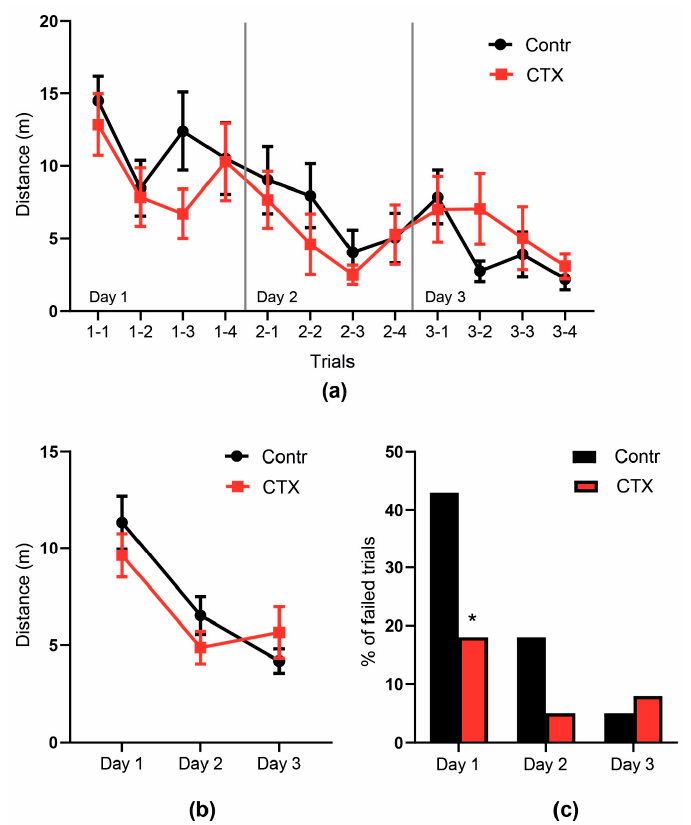
Figure 6. The behavior of CTX-treated rats in the Morris water maze. ( a ) distance traveled from the start point to the hidden platform during the 90-s trial, ( b ) the rate of failed trials during each day, * significant differences between the groups, Fisher’s exact test, p < 0.05, ( c ) mean distance traveled during four trials each day.